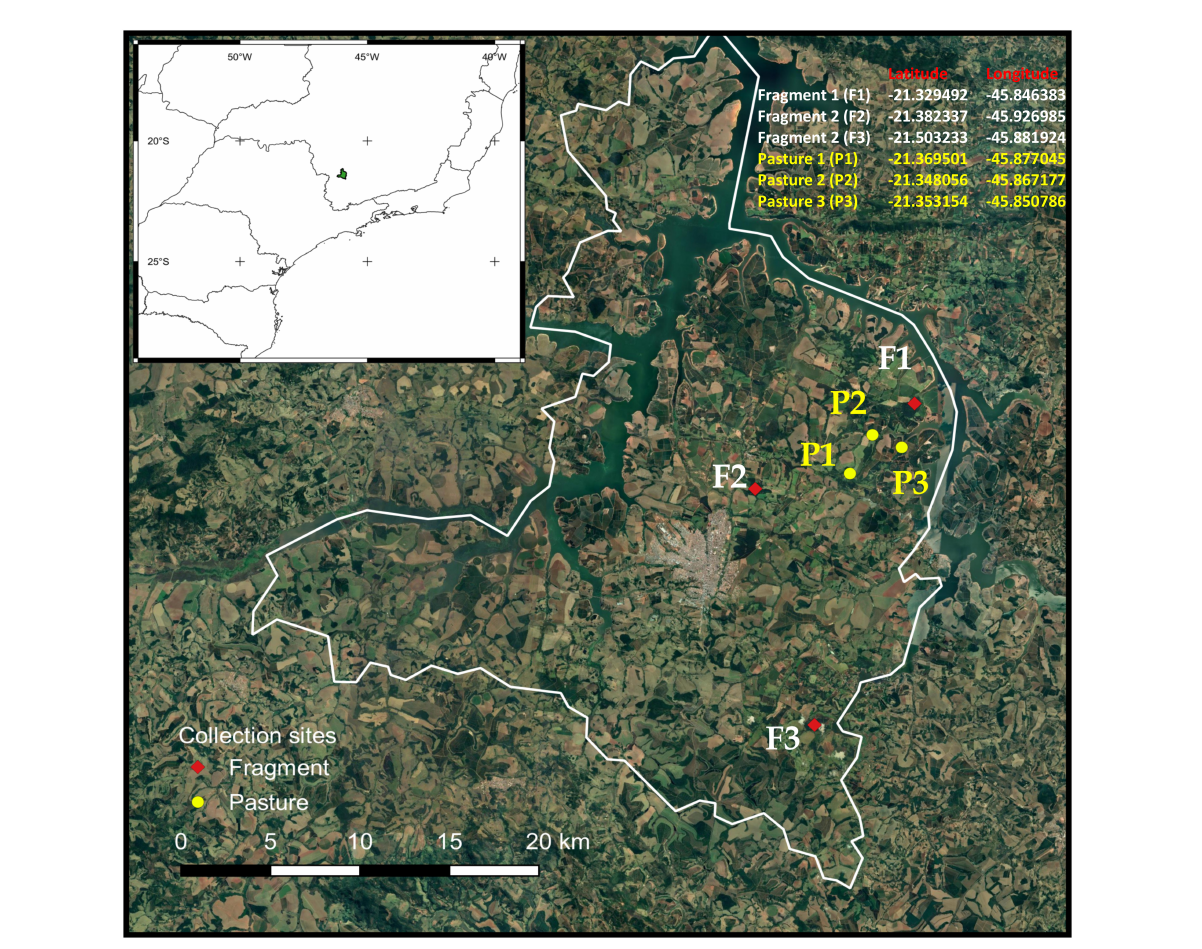
FIGURE1 Map of study site and experimental design. Dung removal was evaluated in the Alfenas region of the southeastern Brazil, in the state of Minas Gerais.